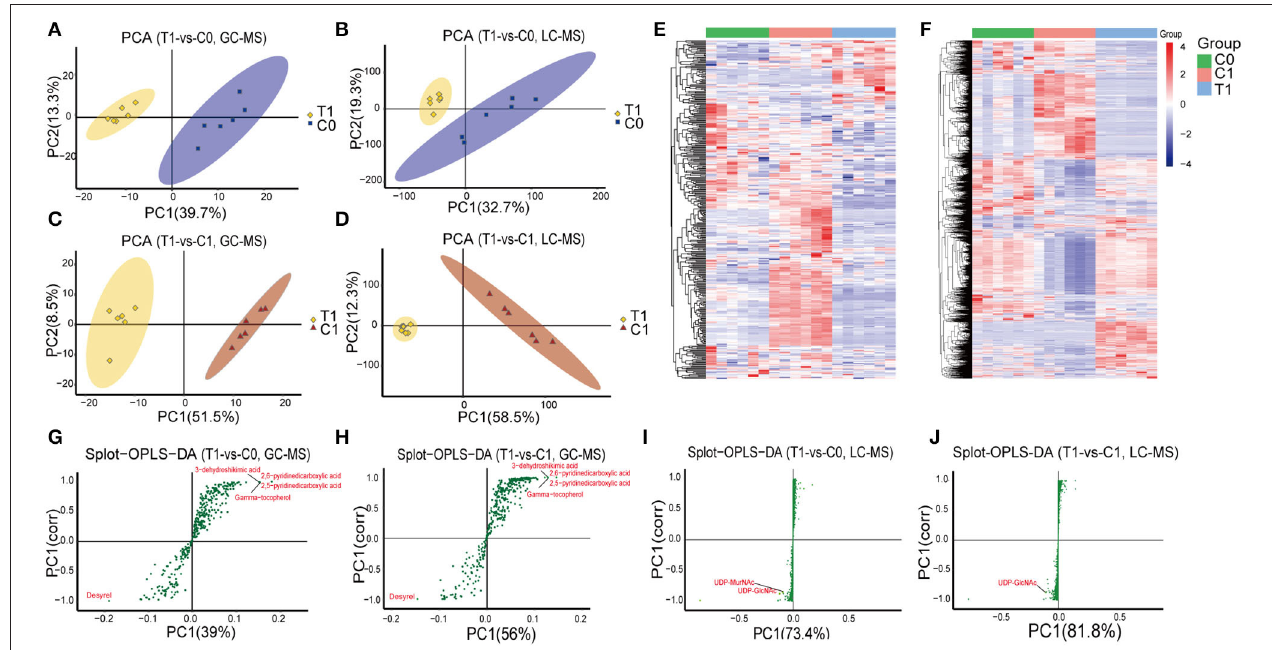
FIGURE 1 | Overview of metabolomics analysis. (A–D) PCA analysis; (E, F) Heatmaps of identified metabolites; (G–J) Graphs of OPLS-DA model, points farther from the origin represent metabolites that contribute more to group discrimination. T1: BBR-exposed group; C0: initial control group; C1: growth control group.